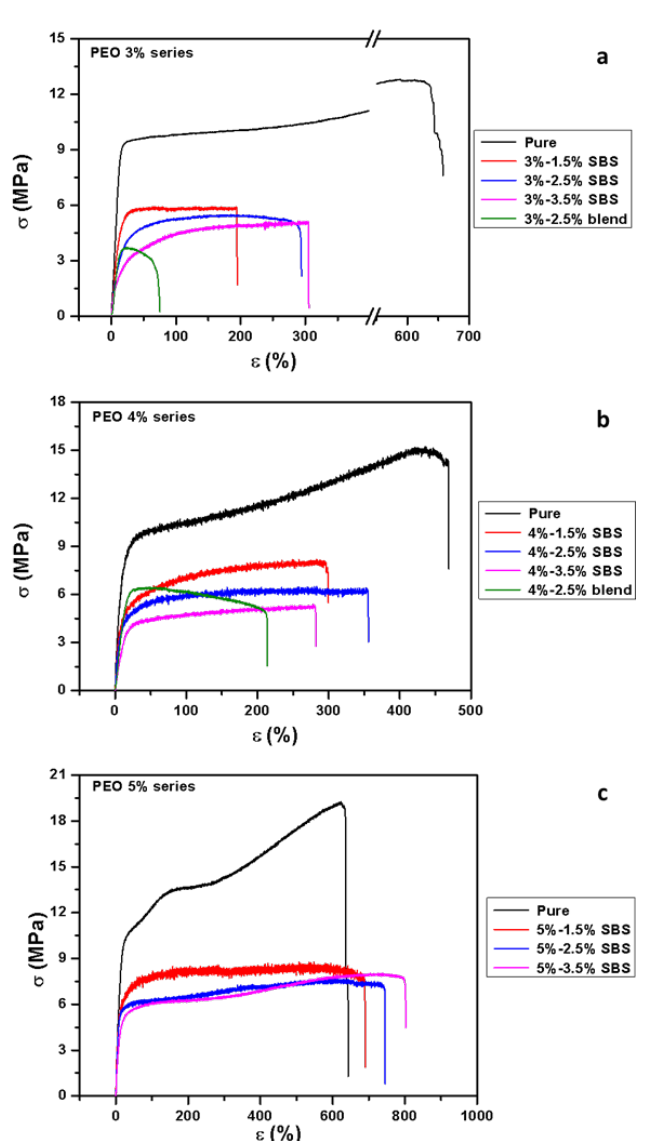
Figure 8. Stress-strain curves of electrospun fiber mats: ( a ) PEO 3% series; ( b ) PEO 4% series; ( c ) PEO 5% series. Table 3. General tensile properties of electrospun fiber mats of pure PEO, blend PEO/PANI, and side- by-side (SBS) PEO/PANI.